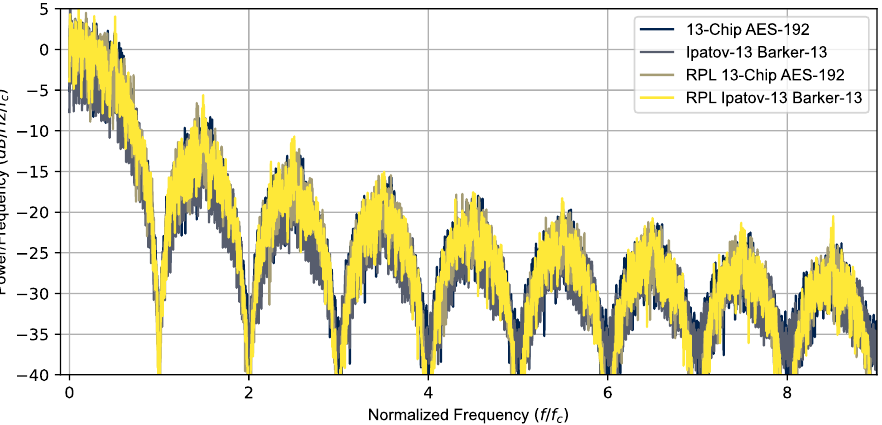
Figure 3. Power spectral density overlay for all simulated signals. All the signals have similar